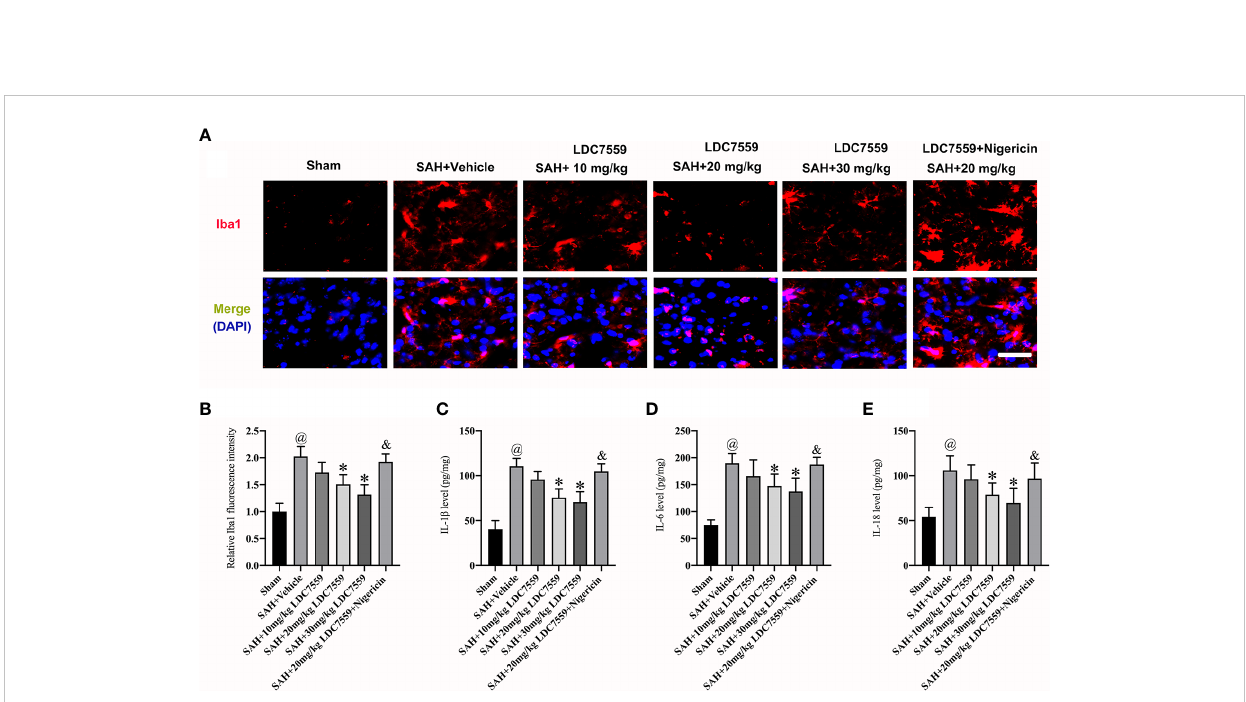
FIGURE 2 LDC7559 mitigated microglial activation and neuroin fl ammation after SAH. Representative brain sections (A) and measurement of Iba-1 staining (B) (n = 6 per group). Scale bar = 50 m m. Measurement of IL-1 b (C) , IL-6 (D) , and IL-18 (E) expressions (n = 6 per group). Values are presented as the mean ± SD. @ P < 0.05 compared with sham group, * P < 0.05 compared with SAH + vehicle group, & P < 0.05 compared with SAH + 20mg/kg LDC7559